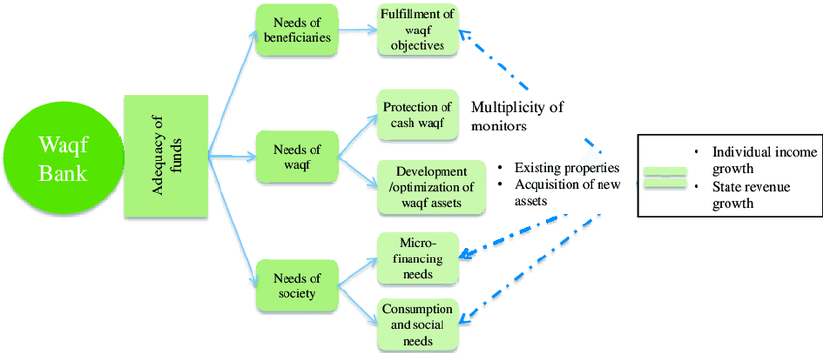
Figure 1. Waqf Bank and its Utility to waqf and society (source: Mohammad 2015).